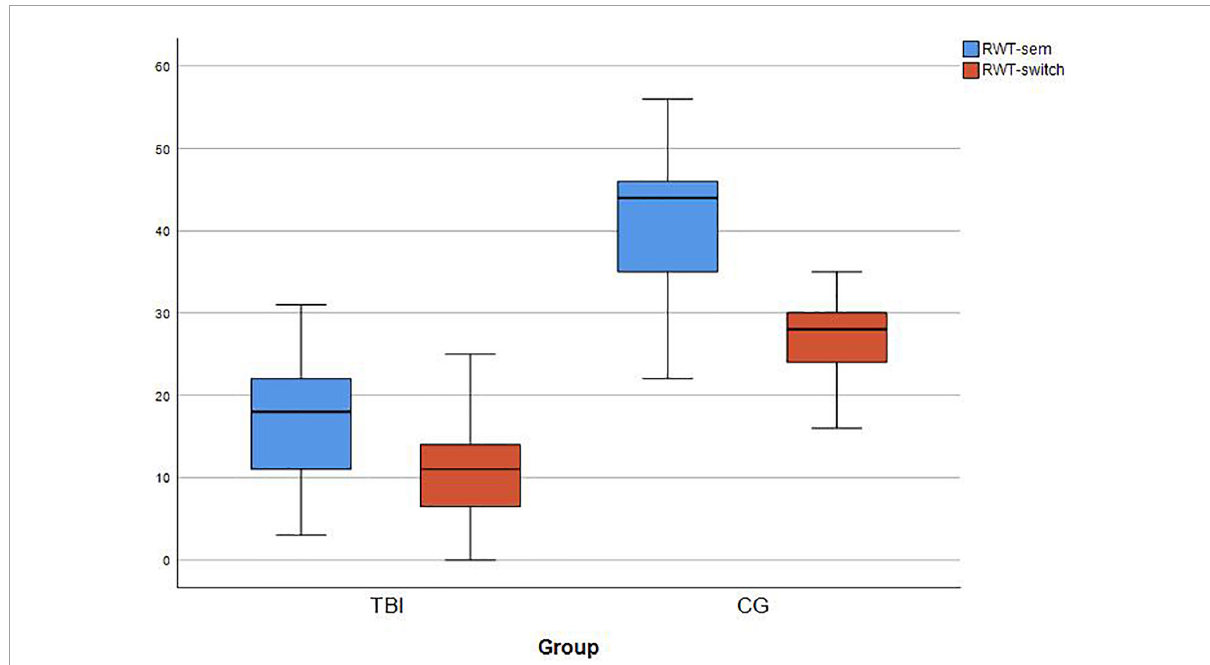
FIGURE2 Boxplots for RWT raw scores for IwTBI and the Control Group on the two conditions of the verbal fluency task. RWT-sem: semantic fluency for “food”; RWT-switch: switching category “sports and fruits.” Each task was performed for 2 min.